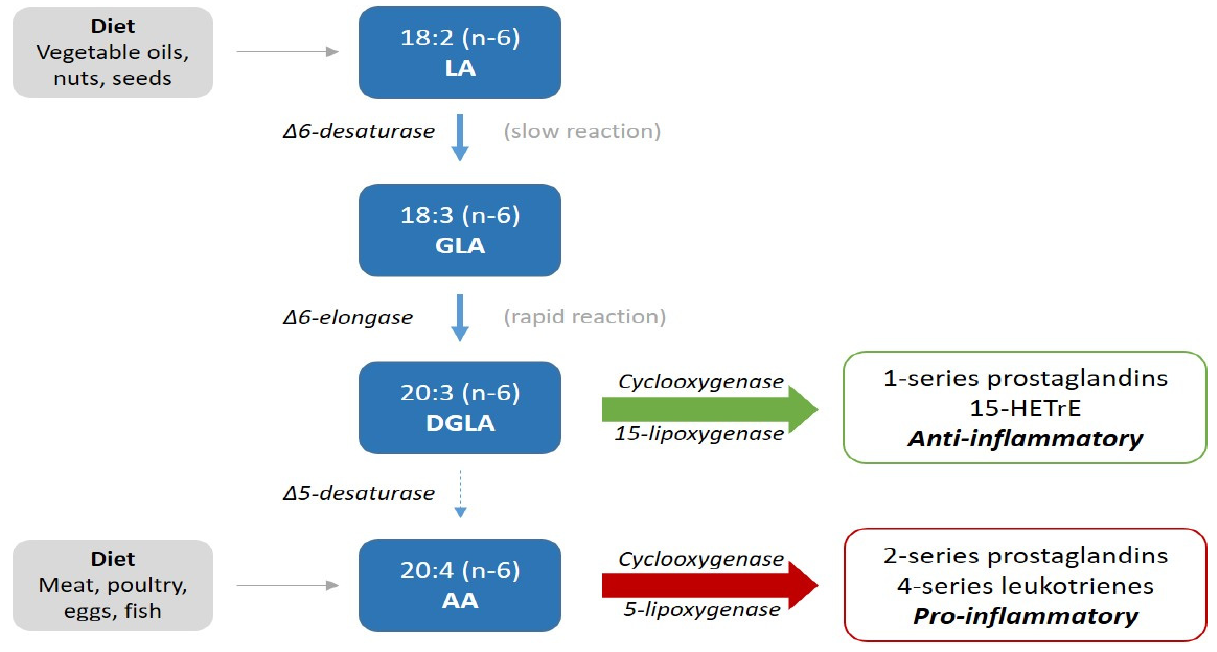
Figure 1. Illustration of the metabolic pathway of n -6 fatty acids.